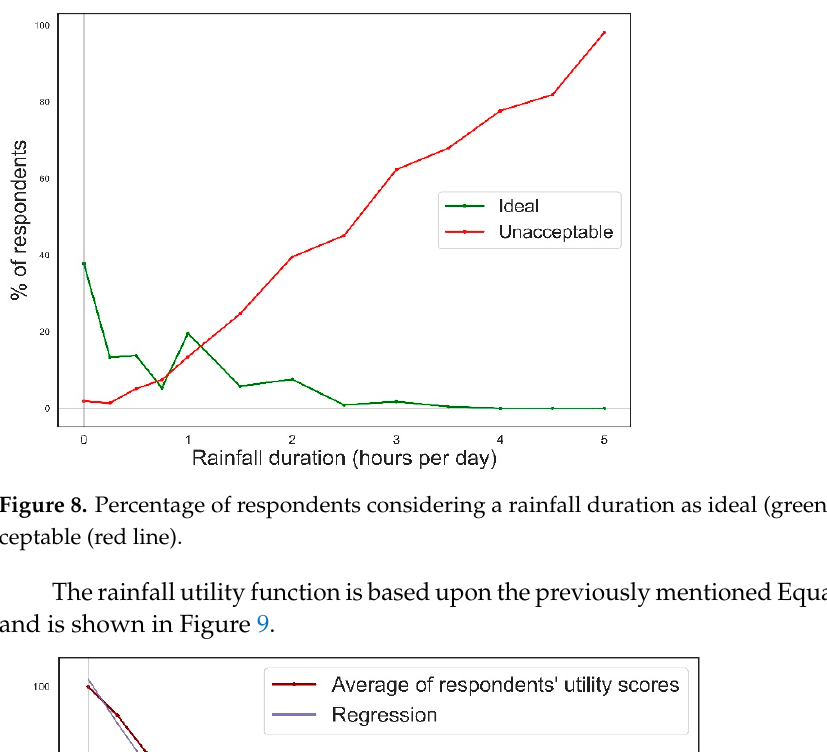
18 of 26 Figure 7. Empirical utility function for ambient air temperature in urban tourism. The empirically estimated equation reflecting the utility function TU n for urban tourism associated with an ambient air temperature T n (in °C) is 𝑇𝑈 (cid:3041) = 263,0451𝑒 (cid:2879)(cid:4666)(cid:3082)(cid:4667) (cid:3278) ⋅ 𝛾 (cid:4666)(cid:3030)(cid:2879)(cid:2869)(cid:4667) 𝑤𝑖𝑡ℎ 𝛾 = 𝑇 (cid:3041) − 𝑙𝑜𝑐 𝜎 (26) with the values of coefficients c, loc, and σ shown in Figure 7. The utility function is valid for temperature values between 10 °C and 41 °C as this was the range explored in our questionnaire. 4.3.2. Rainfall Figure 8 presents the percentage of respondents considering different values of rainfall duration as ideal and unacceptable. As shown, the great majority of respondents (about 90%) prefer a daily rainfall duration of 1 h or less for urban tourist activities, with